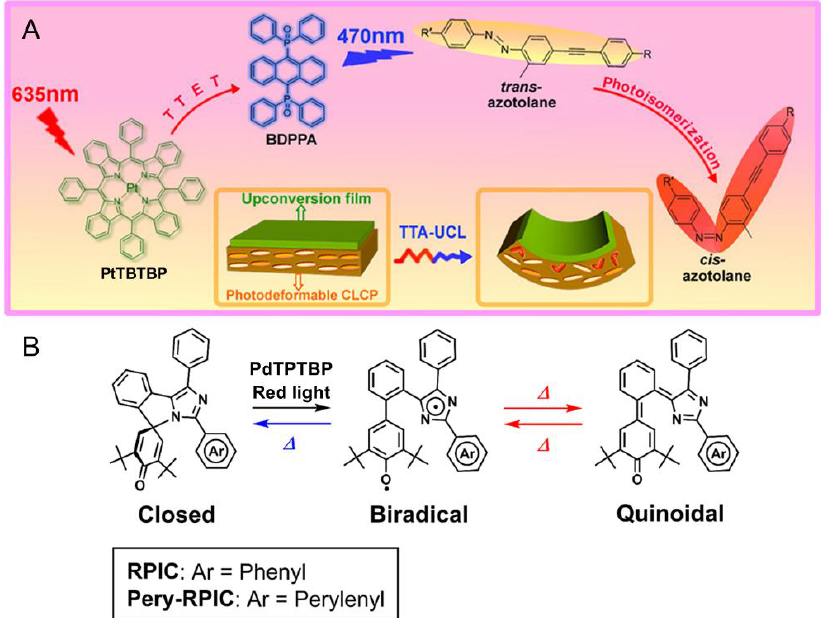
Figure 3. ( A ) Schematic illustration of liquid-crystal soft actuator modulated by red light based on TTA-UC. Reprinted with permission from ref. [76]. Copyright 2013 American Chemical Society. ( B ) Chemical structure of Pery-RPIC and its photoisomerization reactions driven by TTA-UC. Reprinted with permission from ref. [77]. Copyright 2019 American Chemical Society.